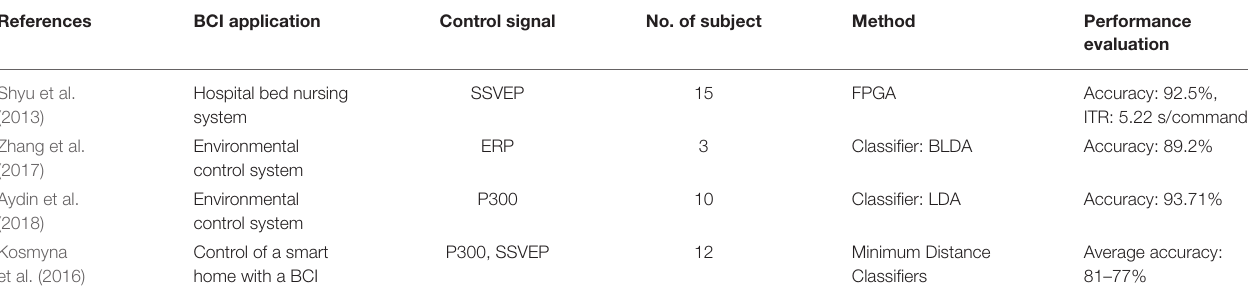
TABLE 10 | Summary of EEG-based BCI environmental control